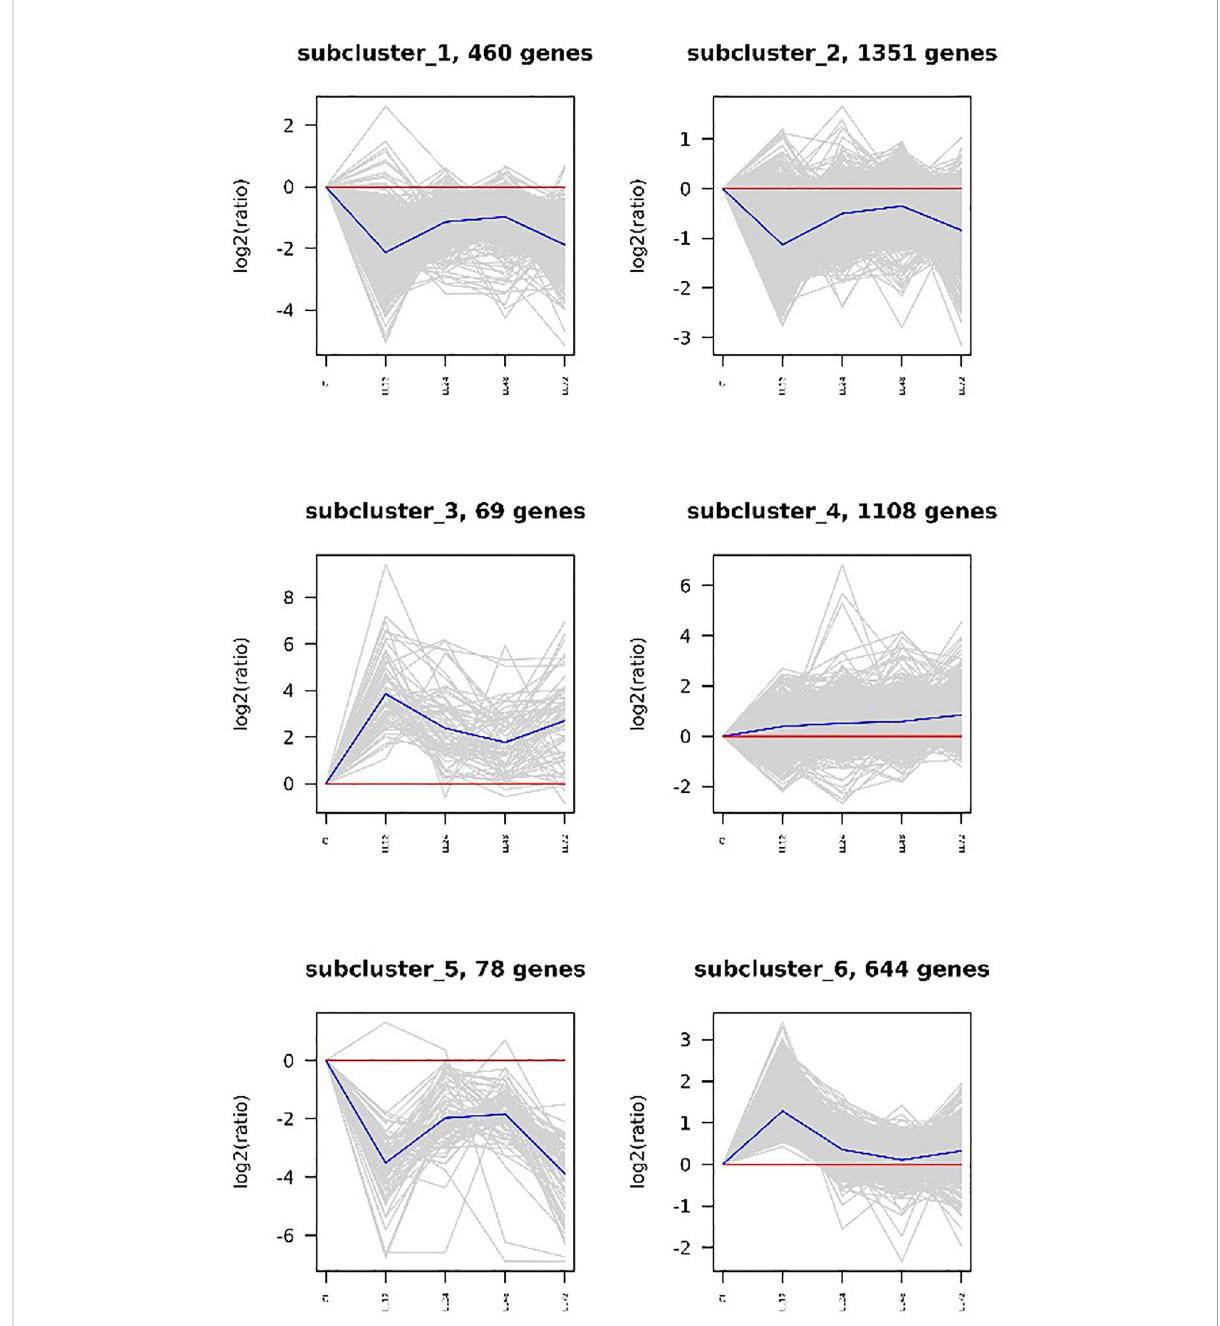
FIGURE 6 DEGs clustering analysis of low salt